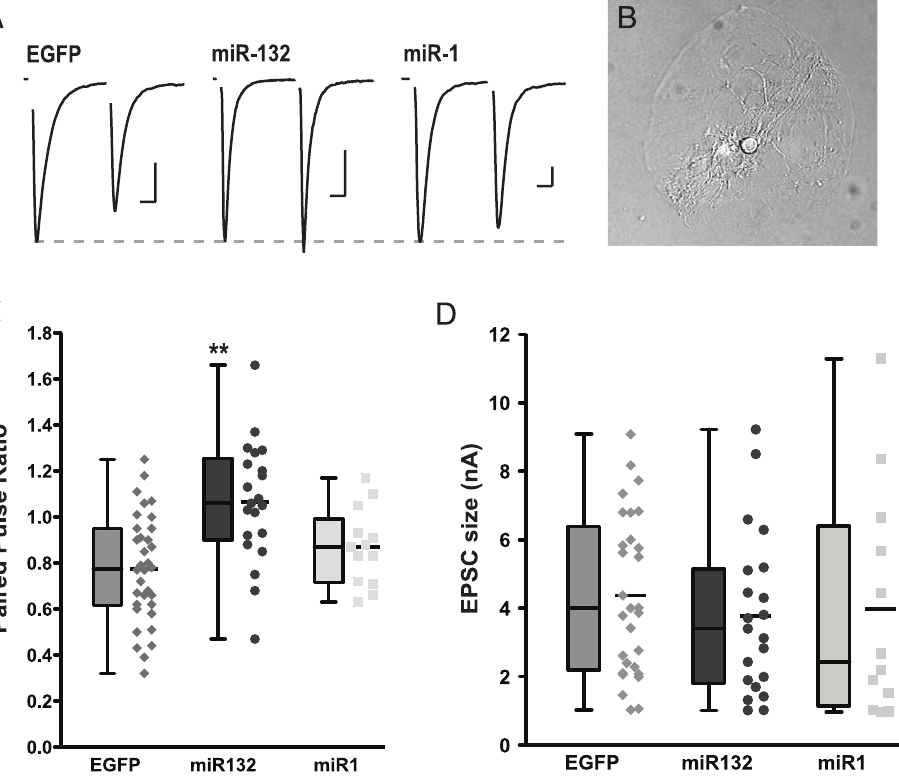
Figure 1. Overexpression of miR132 increases short-term facilitation without affecting basal release probability. (A) Representative traces showing typical paired-pulse responses from EGFP-, mir132-, and miR1-overexpressing neurons with stimulus artifacts and presynaptic action currents blanked for clarity. Traces have been normalized to the first response in the pair to compare facilitation. (scale bars: 1nA, 10ms) (B) DIC image of a representative autaptic neuron growing in isolation on a microisland of permissive substrate. (C) The PPR was greater in neurons overexpressing miR132 relative to EGFP and miR1 control neurons (miR132 PPR was 1.4 times EGFP PPR and 1.2 times miR1 PPR; **, P , 0.005). (D) EPSC size was not significantly different between miR132-overexpressing and EGFP and miR1 control groups. Box plots represent quartiles, and whiskers show min and max values, while adjacent scatter plots show individual data points with mean.